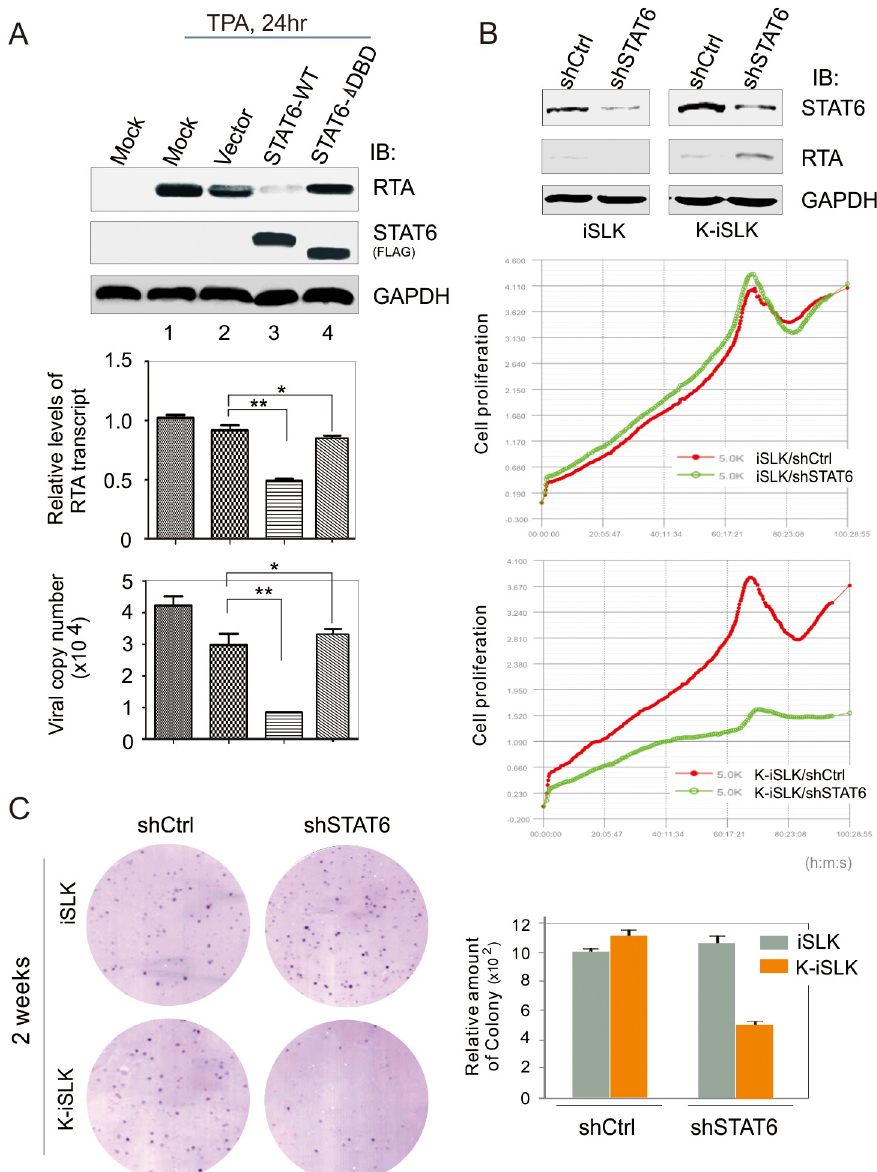
Fig 9. STAT6 is crucial for KSHV to block viral lytic replication and drive cell growth. ( A ) Introduction of intact STAT6 inhibits RTA transcription and virion production. HEK293/Bac36 cells (mock) or HEK293/Bac36 cells transfected with wild-type (WT) or DBD-deleted mutant ( Δ DBD) of exogenous STAT6 or vector alone, at 48hr post- transfection, were individually treated with TPA/Sodium butyrate for 24 hr before harvest. Equal amounts of cells were divided for immunoblotting against RTA, STAT6 and GAPDH as indicated in the figure, and RNA extract for quantitative PCR of RTA transcription. The supernatants from culture were purified to quantitate virion production. The statistical significance was evaluated and p < 0.05 indicated as double asterisks. ( B ) STAT6 knockdown activates RTA expression and reduces KSHV-infected cell growth. iSLK and K-iSLK cells were individually transfected shSTAT6 or shCtrl control. Immunoblotting analysis of endogenous STAT6 and RTA was carried out at 48hr post- transfection. Equal amounts of transfected cells were seeded for real-time monitoring of cell proliferation over a four- day period (bottom panel). ( C ) STAT6 knockdown reduces KSHV-infected cell colony formation. A representative of colony formation after 2-week culture is shown. The relative amount of colony was calculated from two independent experiments (right